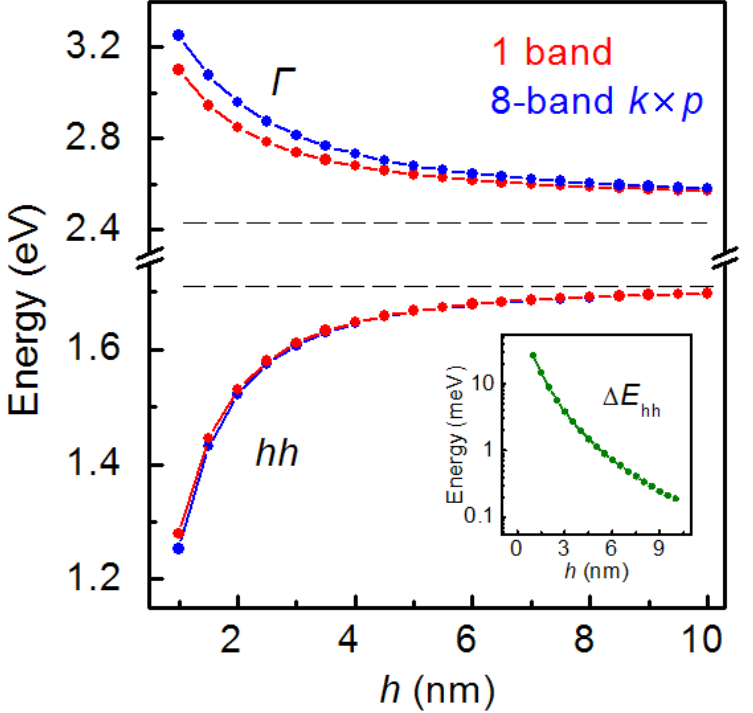
Figure 7. Energy levels for the ground state Г electrons and holes in unstrained GaSb/AlP SAQDs as a function of SAQD height. The calculation was performed in the simple band approach (red line-dots) and in the 8-band k × p approach (blue line-dots). The horizontal dashed lines show the band edge energies of the Г valley of the conduction band and the heavy hole sub-band for GaSb. The energy difference between the hole states, calculated in different approaches, is presented in the inset.